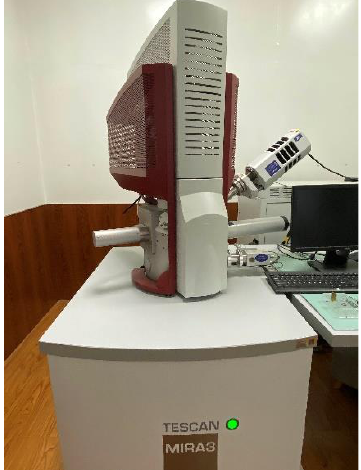
Figure 1. MIRA3 field emission scanning electron